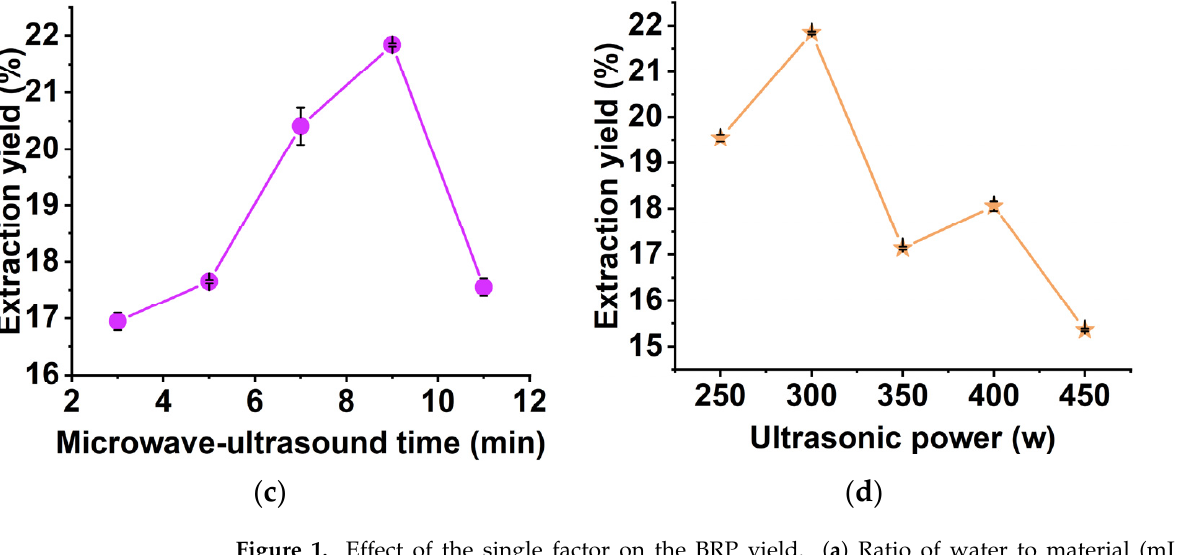
Figure 1. Effect of the single factor on the BRP yield. ( a ) Ratio of water to material (mL/g); ( b ) extraction temperature (°C); ( c ) microwave-ultrasound time (min) and ( d ) ultrasound power (w).